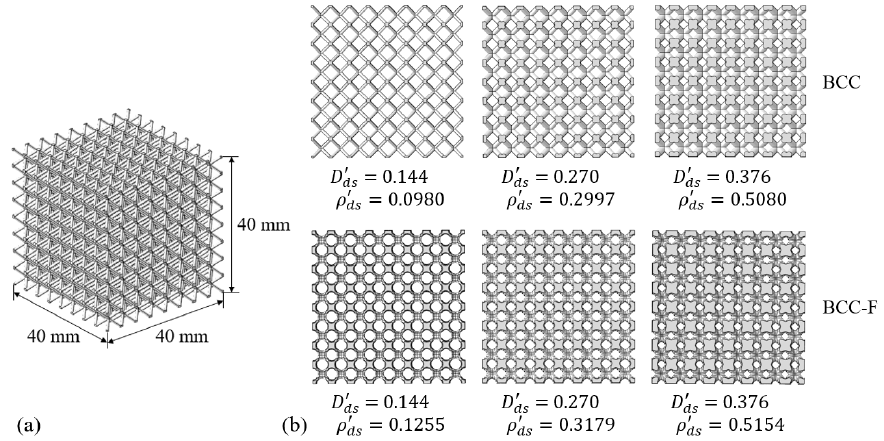
Figure 5. Demonstration of ( a ) dimensions of lattice specimen design and ( b ) CAD models (front view) of BCC and BCC-F specimen designs, where D (cid:48) and ρ (cid:48) represent designed values of relative strut diameter and relative density, respectively.